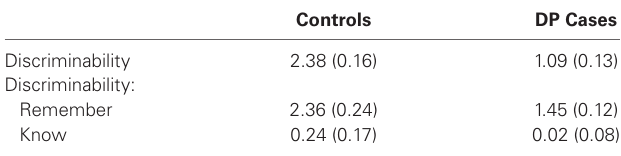
FIGURE 1 | Mock-up examples of the male and female face stimuli used